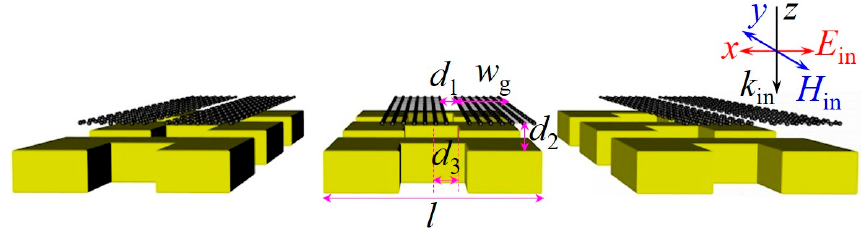
Figure 1. Schematic of the hybrid graphene–metal metamaterial.